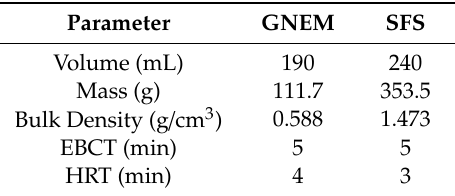
Table 5. Measured generalized nano-engineered media (GNEM) and steel furnace slag (SFS) column characteristics. EBCT: empty bed contact time and HRT: hydraulic retention